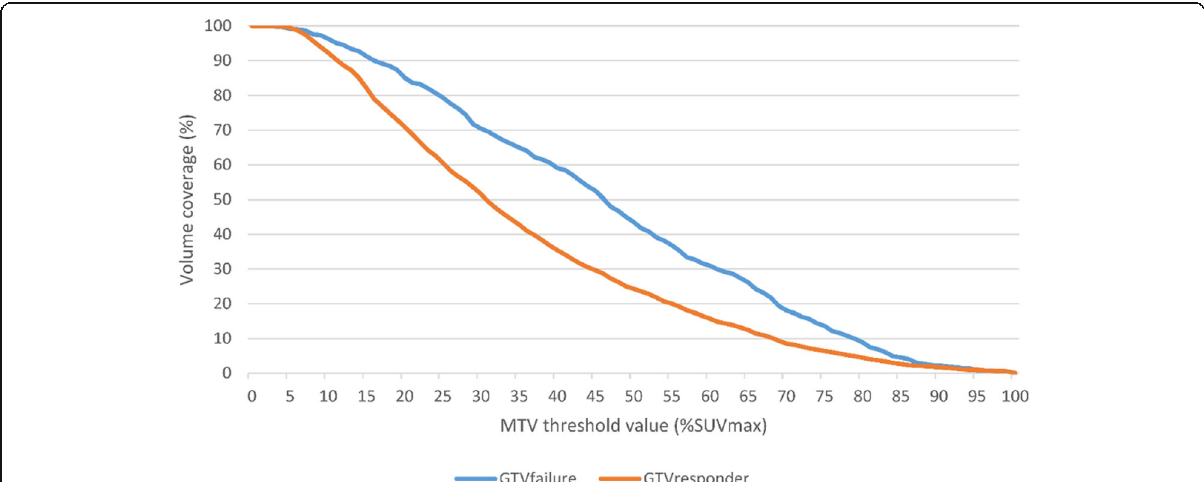
Fig. 4 Percentage of GTVfailure (red line) and GTVresponder (blue line) covered by the MTV as a function of % SUVmax. The MTV covers a higher percentage of GTVfailure than GTVresponder for threshold values ranging from 15% to 80%. However, no threshold value allowed to cover most of GTVfailure without covering most of GTVresponder. GTVfailure recurrence volume within the primary tumor, GTVresponder responder volume within the primary tumor, MTV metabolic tumor volume, SUVmax maximum standard uptake value